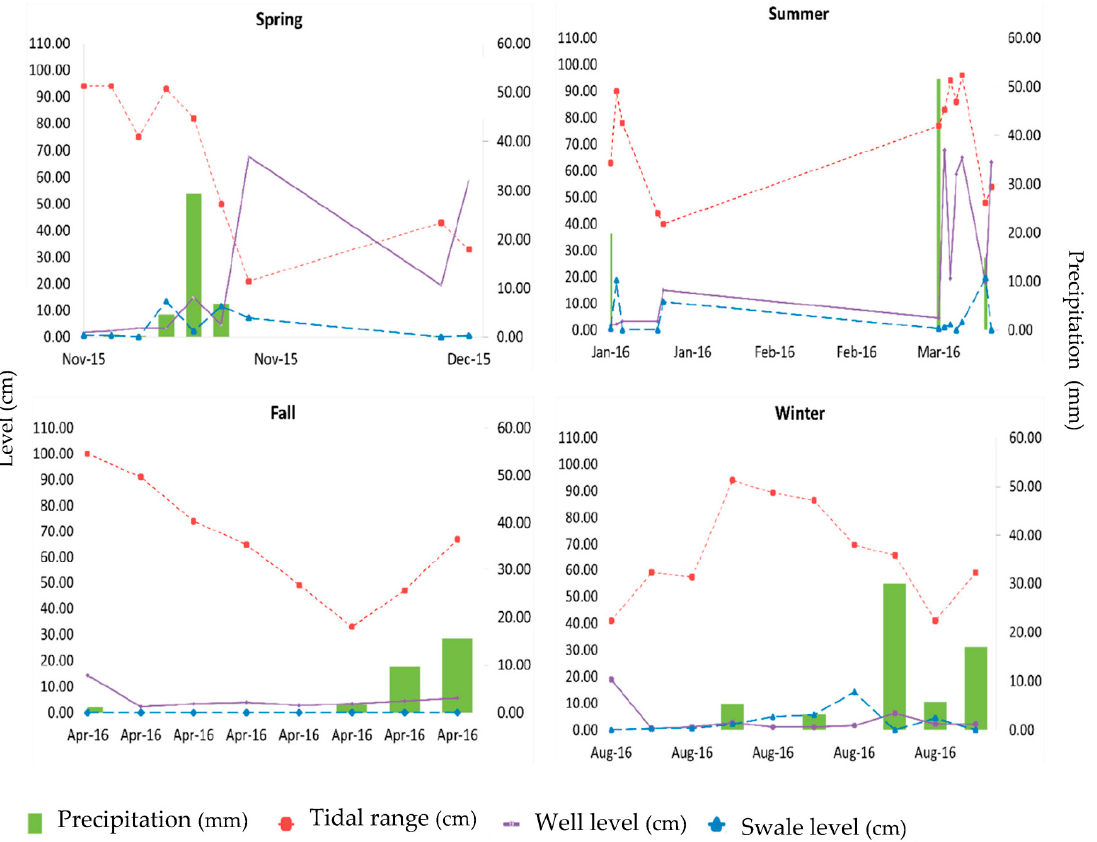
Figure 8. Interface between swale level (difference between maximum level at the swale inlet and outlet height), aquifer level, and tide level.